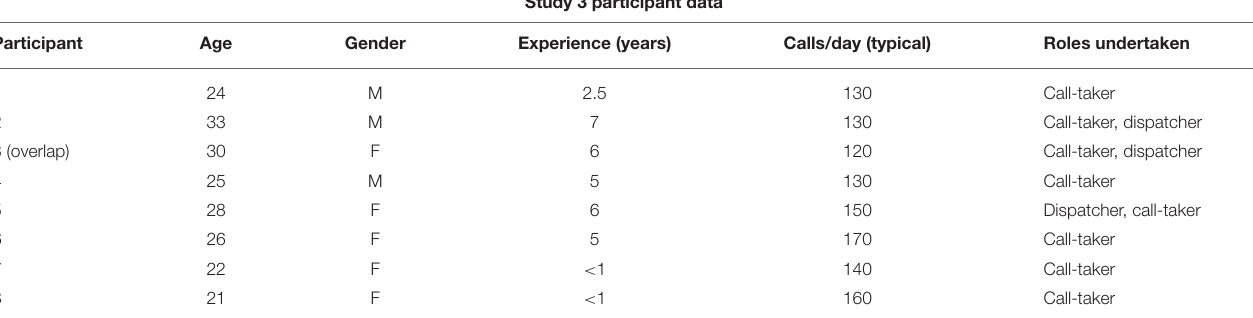
TABLE 3 | Summary of